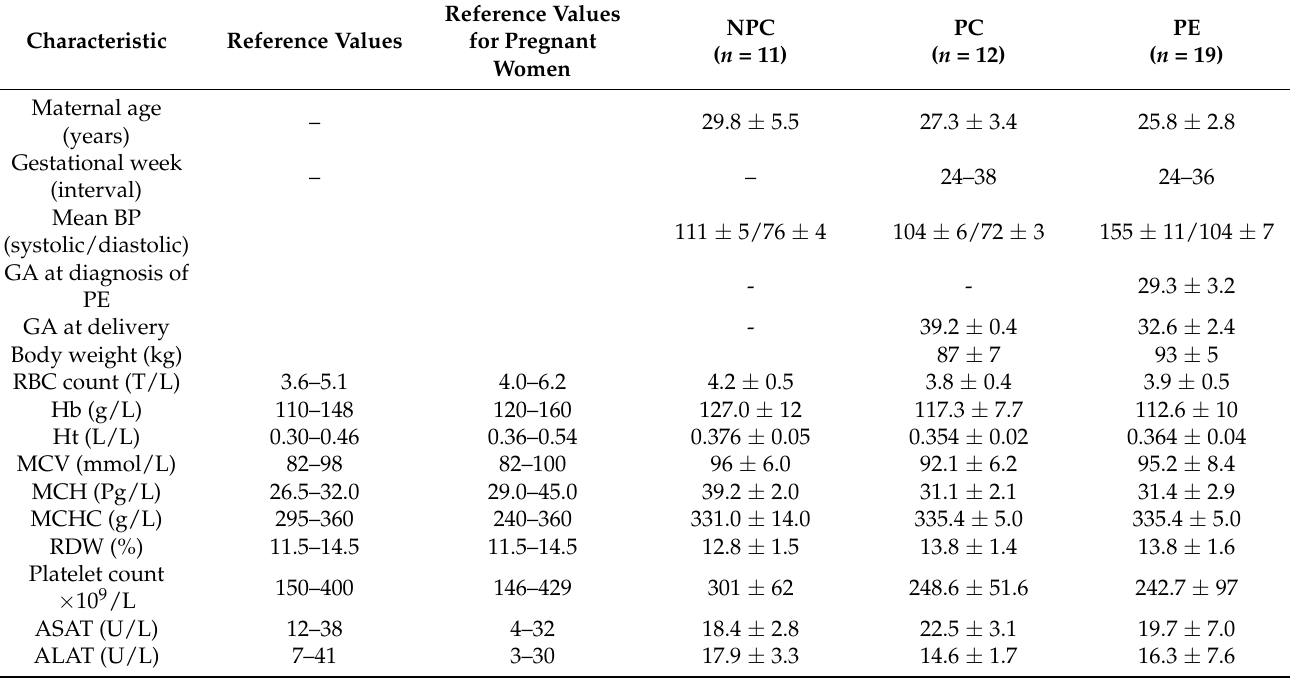
Table 1. Characteristics of the studied groups of non-pregnant controls (NPCs), pregnant controls (PCs), and women with preeclampsia (PE). The maternal age, gestational week, mean blood pressure (BP), gestational age (GA) at diagnosis and at delivery, body weight (BW), and main hematological parameters (RBC count; hemoglobin, Hb; hematocrit, Ht; mean corpuscular volume, MCV; mean corpuscular hemoglobin, MCH; mean corpuscular hemoglobin concentration, MCHC; red cell distri- bution width, RDW; platelet count; aspartate aminotransferase, ASAT; and alanine aminotransferase, ALAT), are presented as mean values and